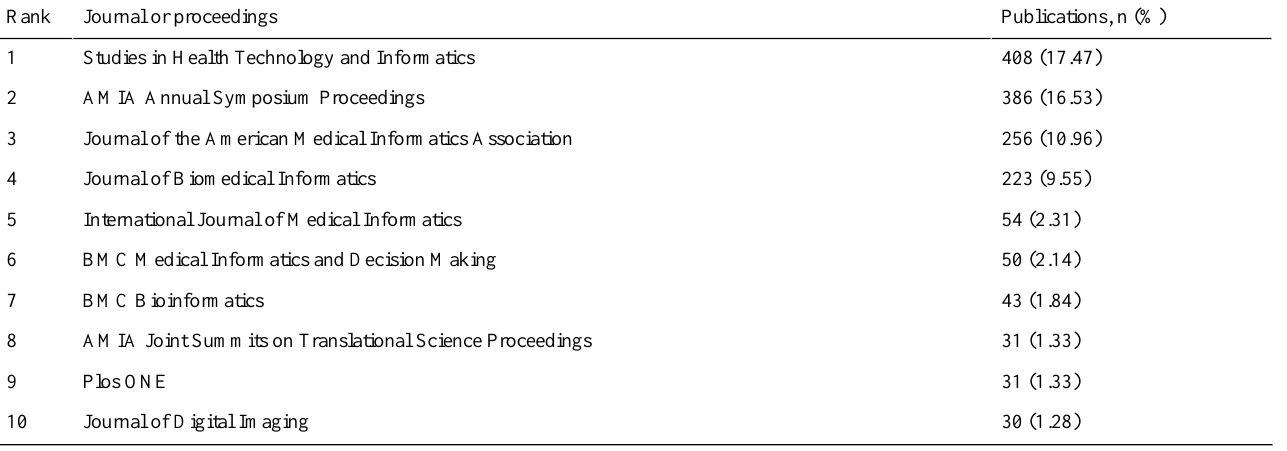
Table 1. Medical natural language processing journal rankings